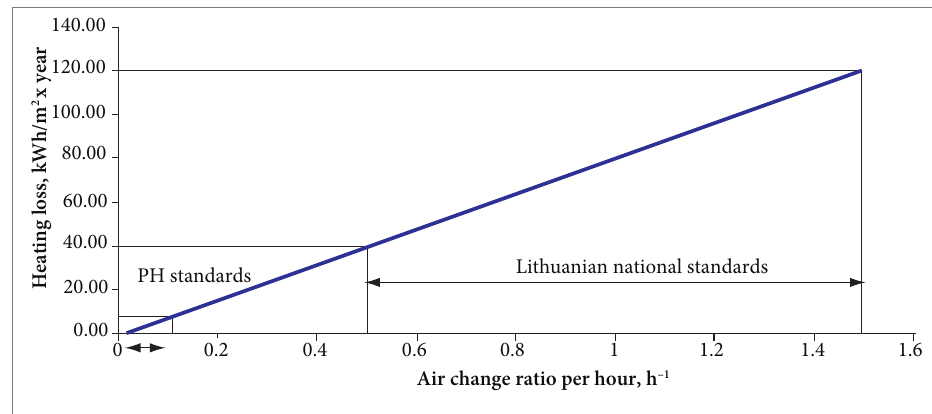
Fig. 6. The dependence of heat loss on the air tightness of the